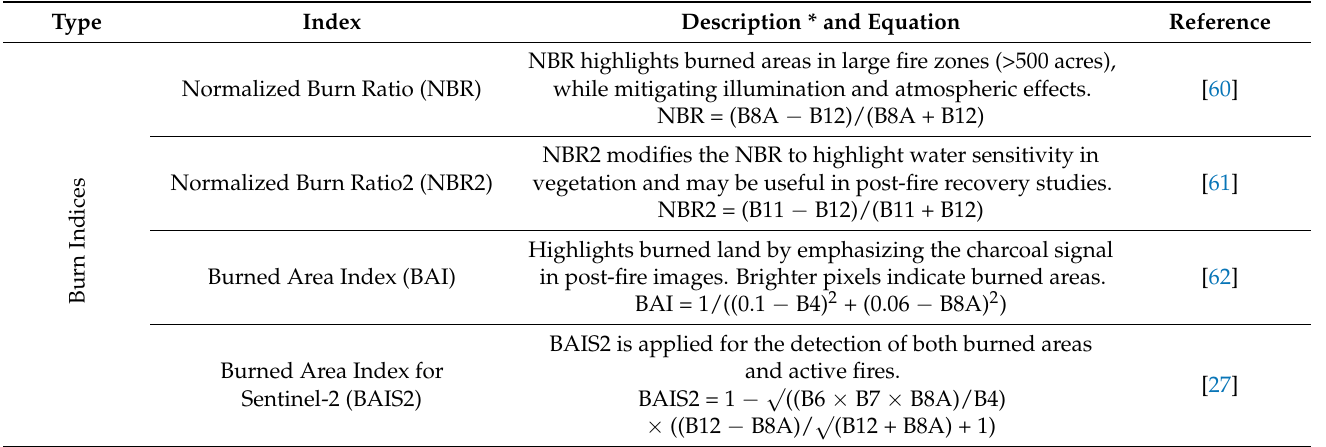
Table 1. The derivatives of Sentinel-2, including burn, vegetation, soil, and water indices, for use in training deep-learning-based models for detecting burned